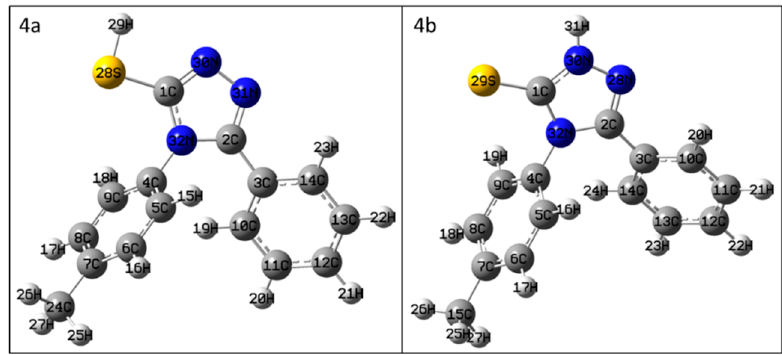
Figure 1. The geometry ‐ optimized structures of compounds 4a and 4b.